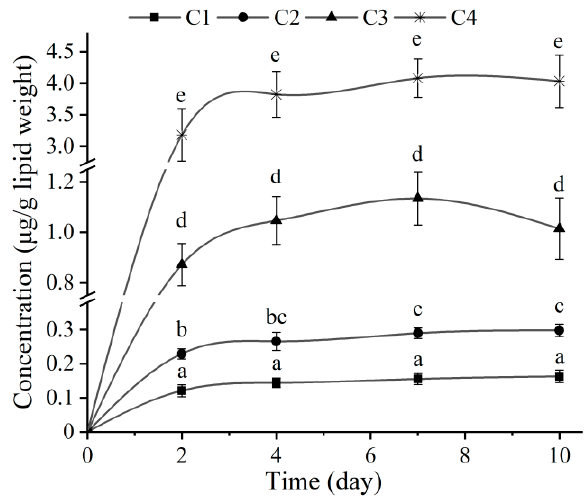
Figure 1. Concentration changes of EHDAB in larvae during 10 days of exposure. C1, C2, C3 and C4 represent the experimental groups with nominal exposure concentrations of 4, 20, 100 and 500 µ g/L, respectively. Values are expressed as the mean ± standard deviation ( n = 3), and different letters above the bars indicate significant differences between treatments and among time for a given treatment at the p < 0.05 level between treatments.